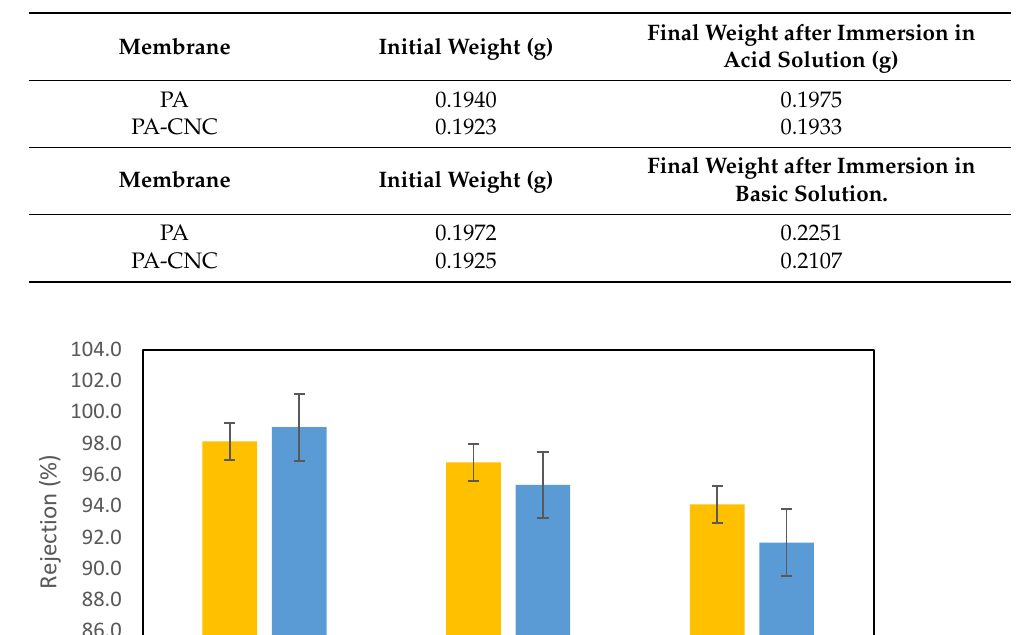
Table 4. Change in weight of both PA and PA-CNC membranes after immersion in 1M NaOH and 1M HCl for two weeks.